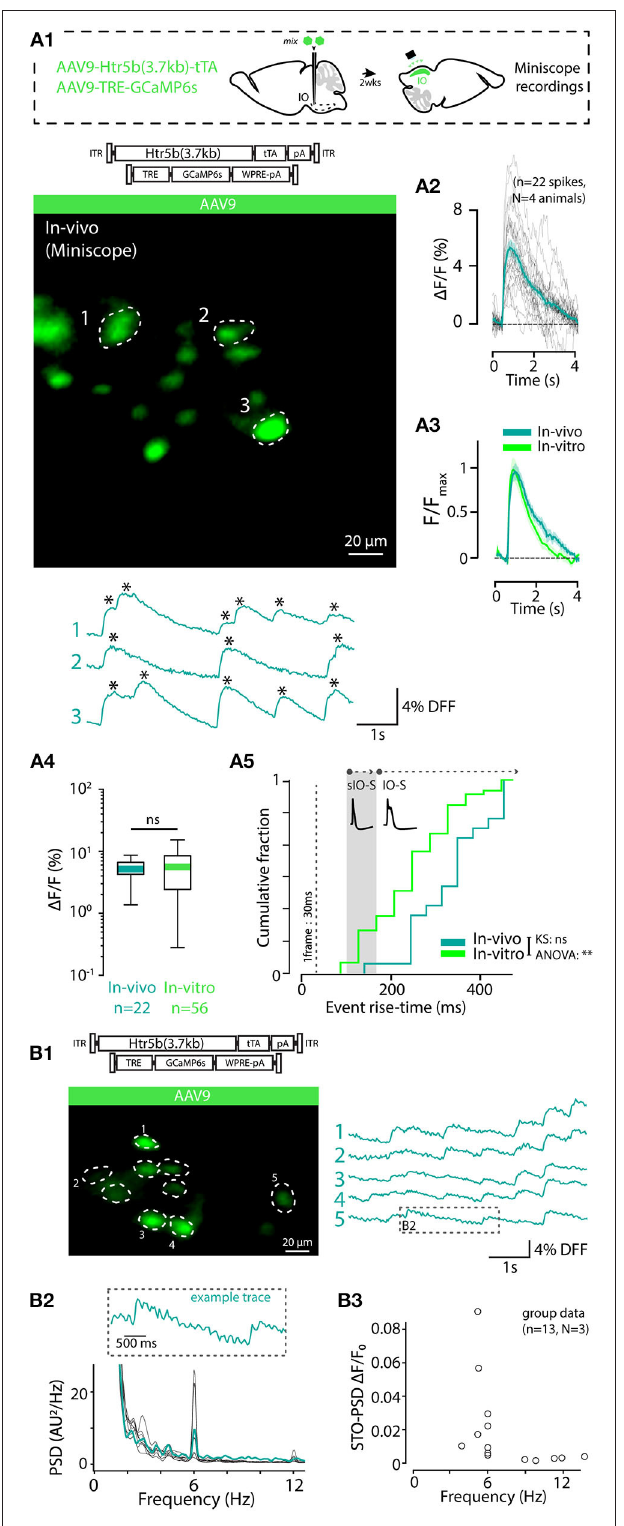
FIGURE 11 | Imaging IO spikes and STOs in vivo . (A) in-vivo calcium spike recording from ventral IO using a GRIN-lens-based miniscope. The schematic on top of the figure describes the approach. (A1) Example image (standard